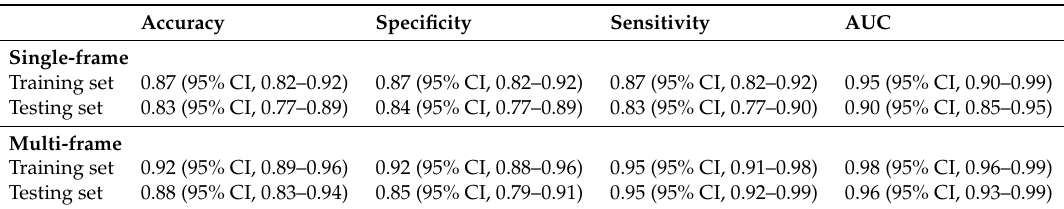
Table 2. Comparison of single-frame and multi-frame analysis using the ensemble deep convolutional neural network (DCNN) for both the training and the test